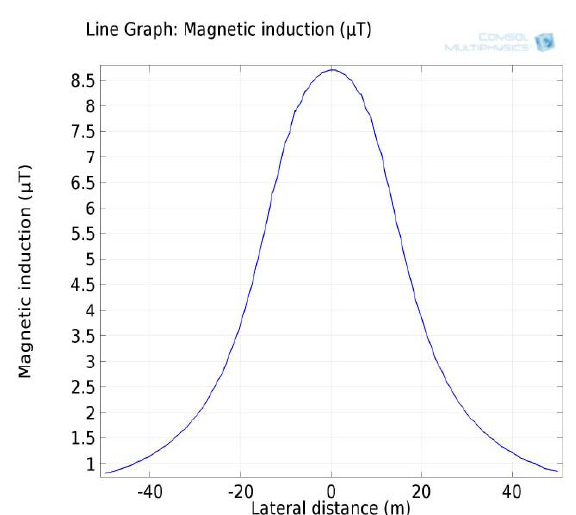
Figure 17: Lateral magnetic induction profile calculated at 1 m above the ground level for different phase configurations of double-circuit 275 kV power line (500 A).